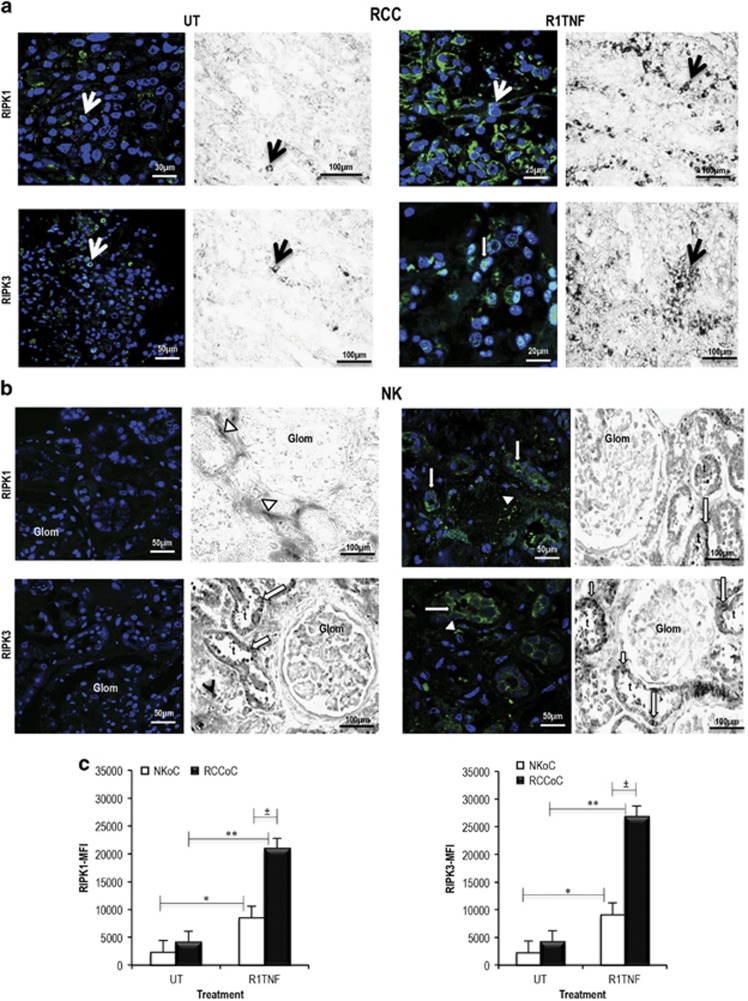
Representative confocal images and light micrographs of the effect of R1TNF on protein and mRNA expression for RIPK1 and RIPK3 in organ cultures of RCC grade 1 and adjacent non-tumor kidney (NK). (a and b) Untreated (UT) cultures from RCC show a rare signal for RIPK1 and RIPK3 protein and mRNA. In contrast, R1TNF-treated cultures show a marked signal of both proteins mainly confined to mTECs (arrows), with RIPK3 also present in nuclei (white shaded arrow). Similarly, UT cultures of NK show a rare signal for both proteins; increased expression of both protein and mRNA is detected in R1TNF-treated cultures mainly confined to normal TECs (white arrows), peritubular capillaries (white arrowheads) and in infiltrating mononuclear cells (black arrowhead) but not in glomeruli (Glom). (c) Representative mean fluorescence intensity (MFI) for RIPK1 and RIPK3 expression in RCC and NK organ cultures. **P<0.01 versus UT, *P<0.05 versus UT, ±P<0.05 versus R1TNF; Bars=mean±S.E.M.; n=3 independent experiments from six separate organ culture experiments with similar results. Nuclei stained with Hoechst 33342. Confocal images: × 40 and × 63 original magnifications; photomicrographs: × 400 magnification